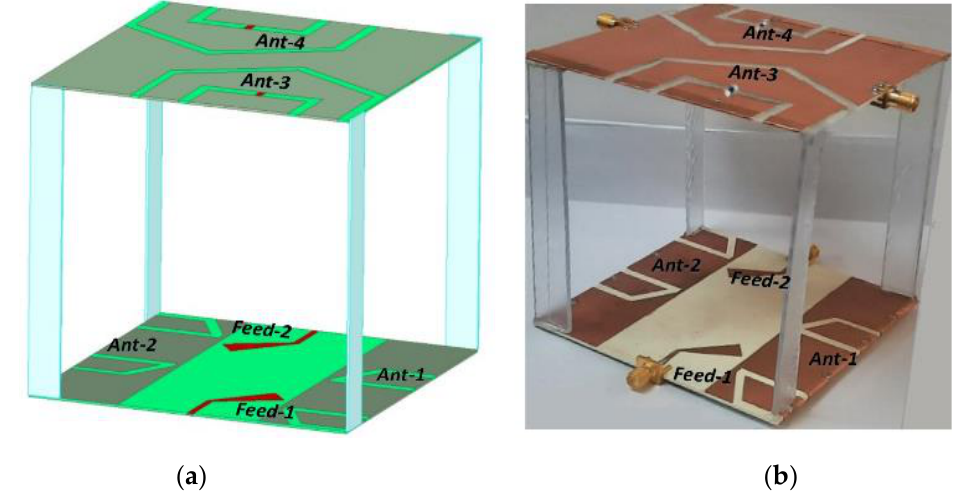
Figure 1. Proposed folded-slot CubeSat MIMO antenna: ( a ) simulated and ( b ) fabricated model. Figure 2a,b illustrate the top and bottom layers of the MIMO antenna as well as the detailed antenna dimensions. Each slot is 2 mm in width. Figure 2c illustrates different antenna layers. The proposed antenna design was fabricated using LPKF S103, and is shown in Figure